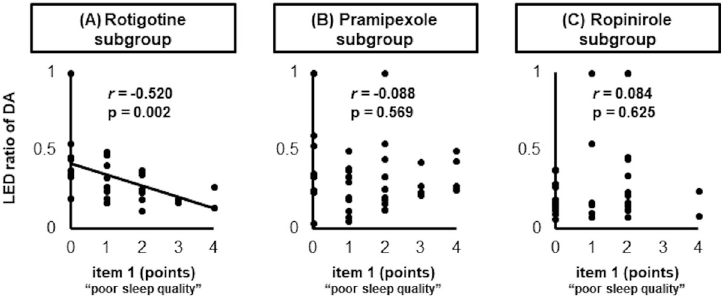
Fig 3. Scatter plots showing the item 1 score and ratio of DA. (A) The LED ratio of rotigotine was inversely correlated with the score for item 1. (B, C) Analyses of the pramipexole and ropinirole subgroups demonstrated no correlations between LED ratio and item 1. P-values were calculated using Spearman’s rank correlation coefficient.